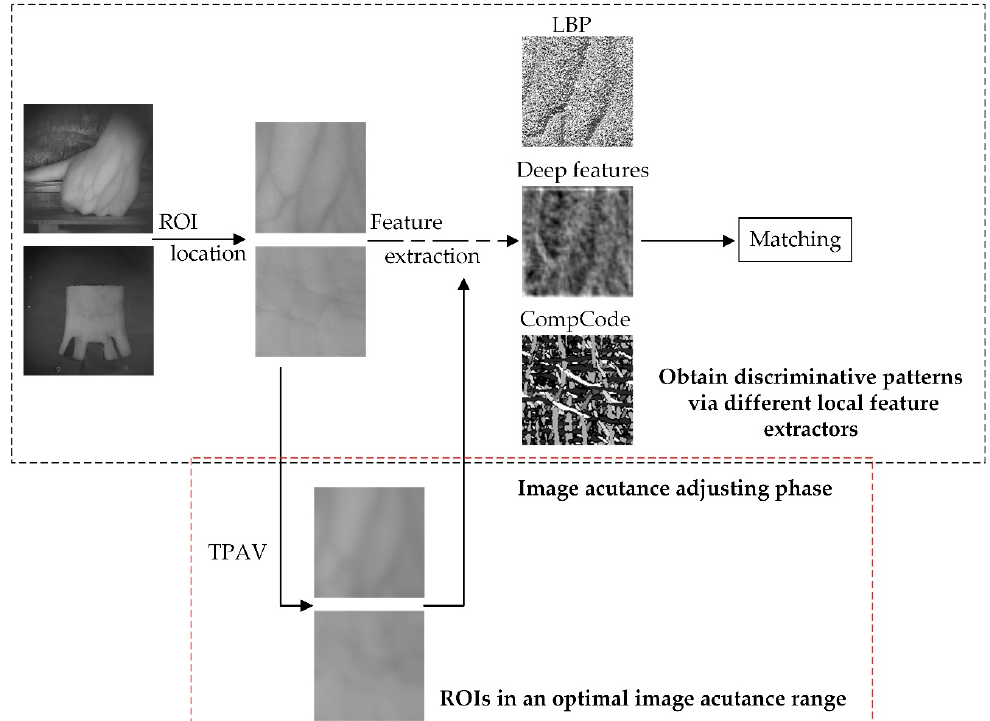
Figure 1. Image acutance adjusting phase in hyperspectral hand recognition.